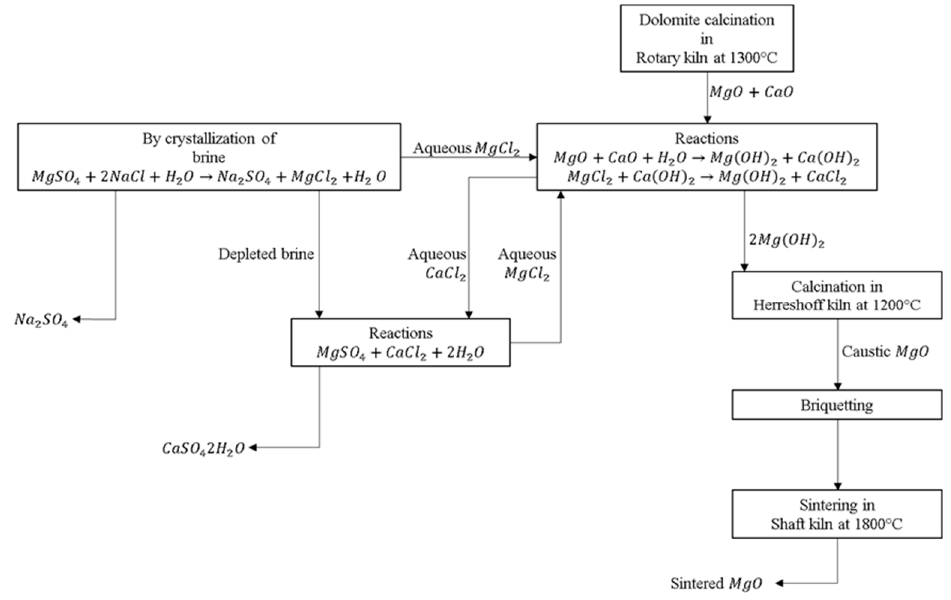
Figure 1. Representative diagram of the process for obtaining caustic MgO in Mexico [11].